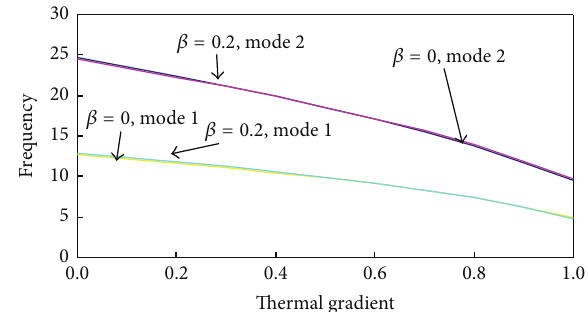
Figure 5: Value of frequency parameter for orthotropic trapezoidal plates for different values of taper constant and fixed values for 𝑎/𝑏 = 0.75 , 𝑐/𝑏 = 0.25 .